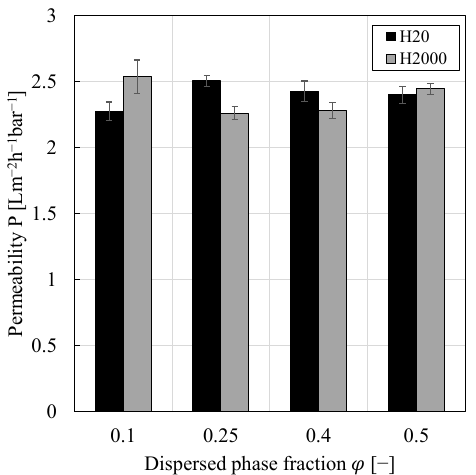
Figure 4. Permeability against dispersed phase fraction for w/o PEs stabilized by 0.5 wt.% of either particle type H20 or H2000. All pressure stepping experiments were conducted at least in duplicate and mean values are shown. Error bars represent the standard deviation. For comparison, the permeability of pure 1-dodecene was 3.58 ± 0.60 Lm − 2 h − 1 bar − 1 .